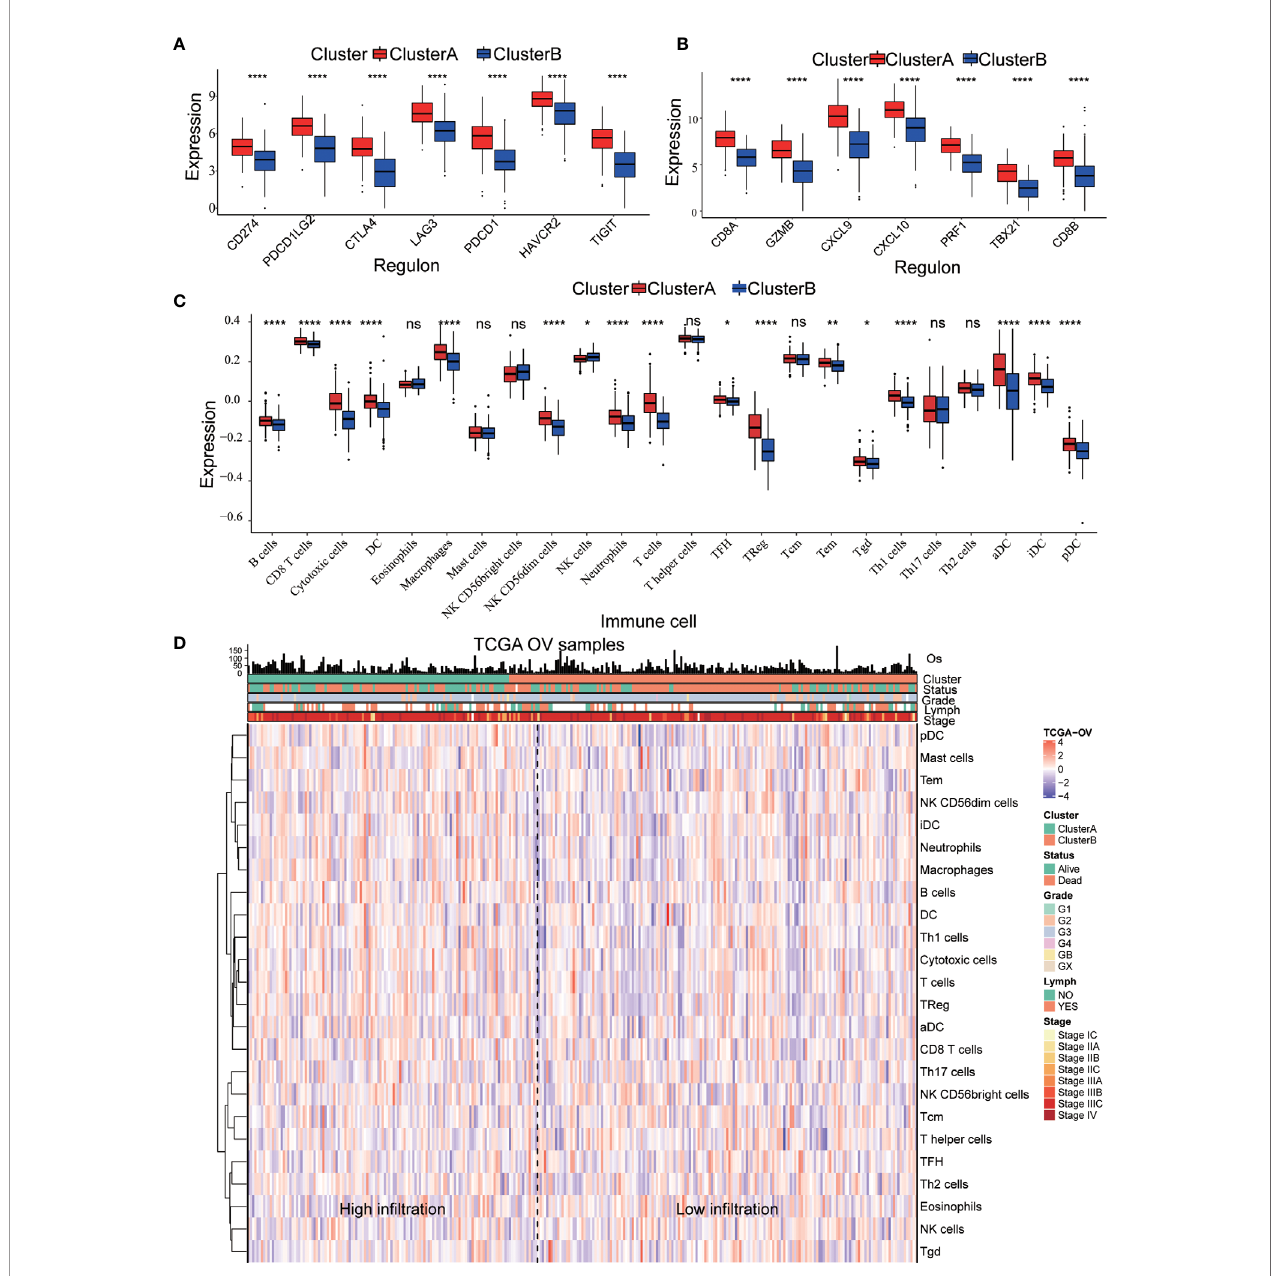
FIGURE 3 | Immune characteristics of cluster A and cluster B (A) Expression pattern of immune checkpoints in cluster A and cluster B (****p<0.0001, **p<0.01; *p<0.05; ns<1). (B) Expression pattern of CD8+ T signature genes in cluster A and cluster B (****p<0.0001, ***p<0.001; **p<0.01; *p<0.05; ns<1). (C) The ssGSEA method quanti fi es the level of in fi ltration of the 24 immune cells in the TIM. Differences in the levels of in fi ltration of the 24 immune cells in cluster A and cluster B (****p<0.0001, ***p<0.001; ns<1). (D) The composite heat map shows the relationship between the risk score, age, grade, lymphovascular invasion indicator, primary site and clinical stage and in fi ltration of the 24 immune